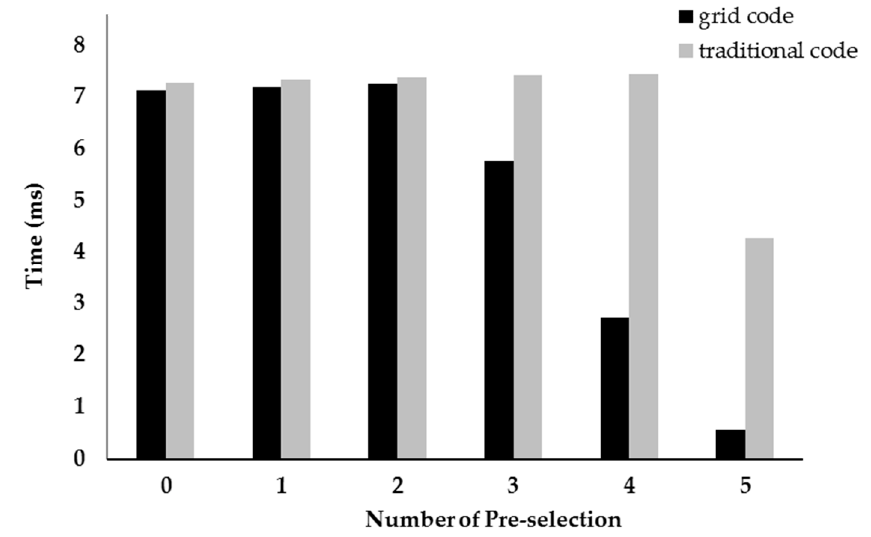
Figure 4. Performances comparison in query efficiency.